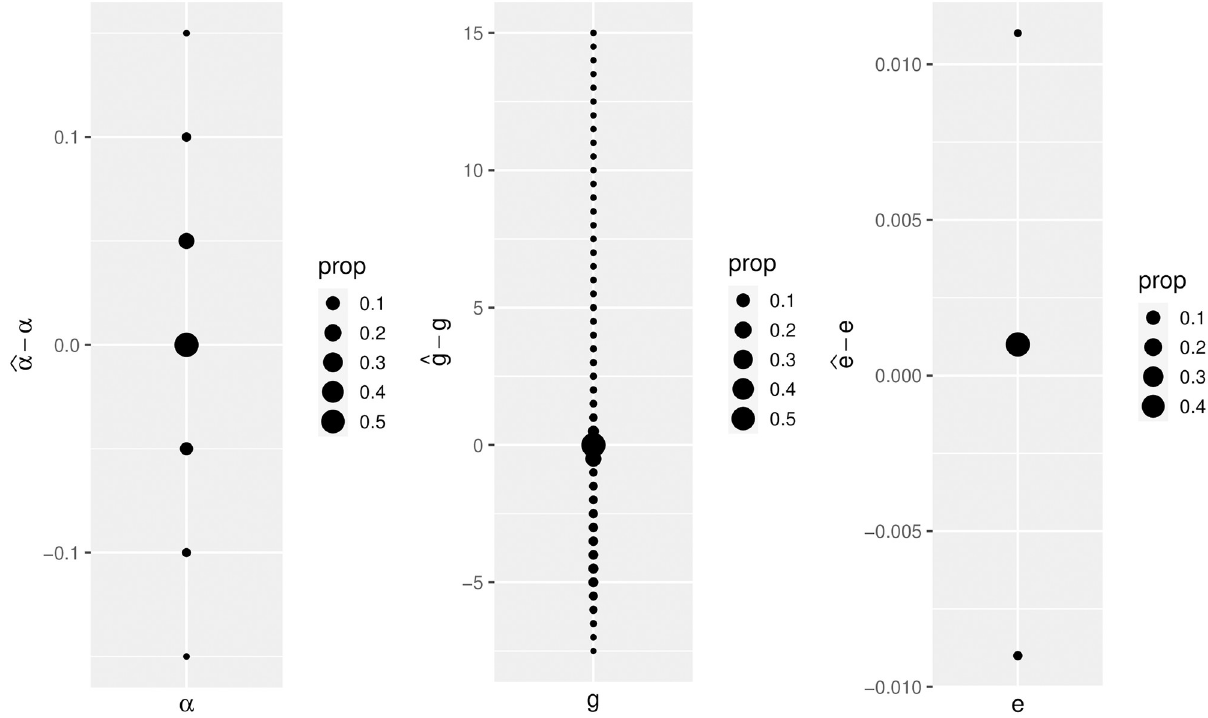
Fig 1. Error for estimating parameters for Beta coalescents with exponential growth and allele misorientation across the parameter grid for ( α , g , e ). The space between the points stems from the grid. Sample size n = 100, 50 independent loci with 100 mutations on average. 500 simulations were performed per parameter